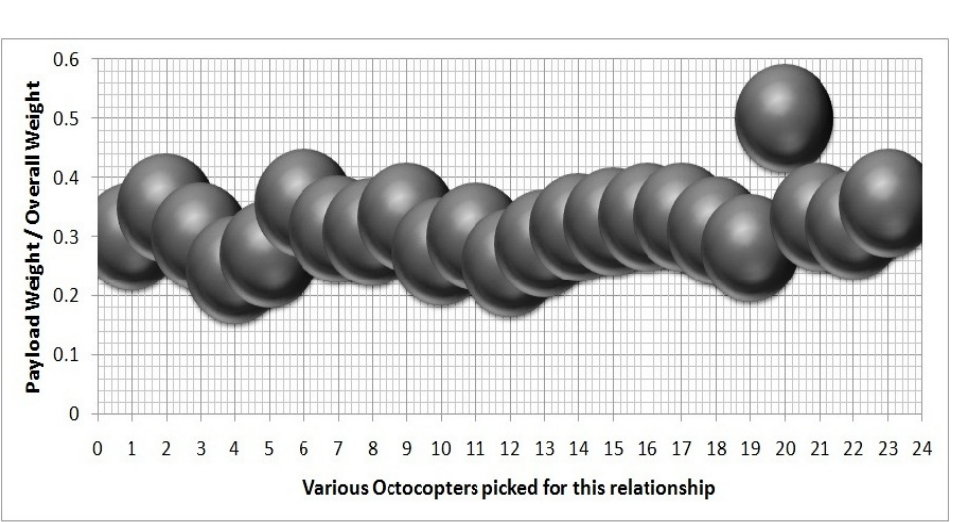
Figure 3. Historical relationship between payload weight and overall weight of octocopter